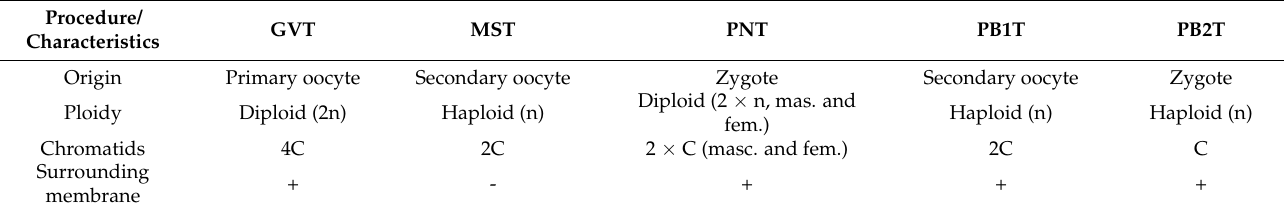
Table 1. Mitochondrial replacement technique comparison.